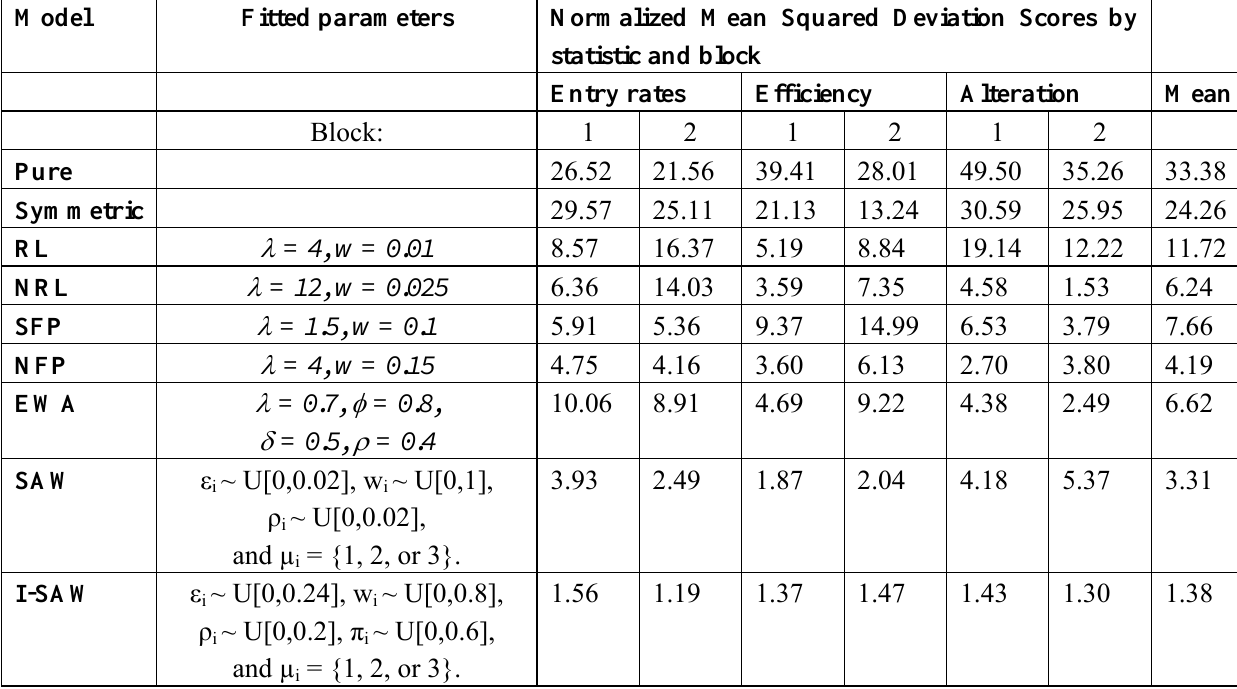
Table 4. The baseline models, the estimated parameters, and the implied normalized MSD scores by statistic and block.